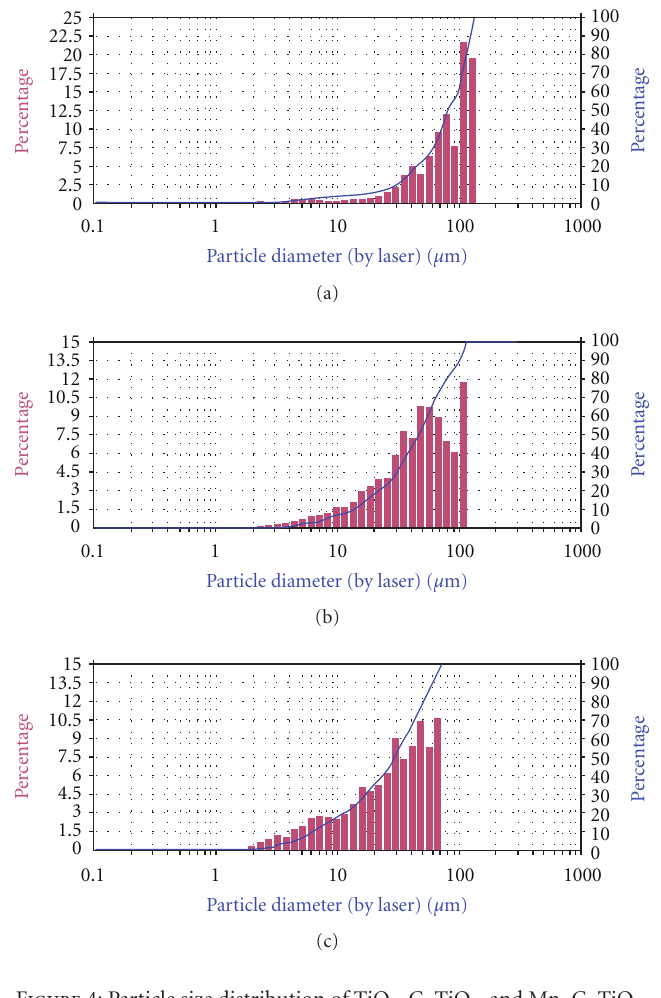
Figure 4: Particle size distribution of TiO 2 , C–TiO 2 , and Mn–C–TiO 2 .